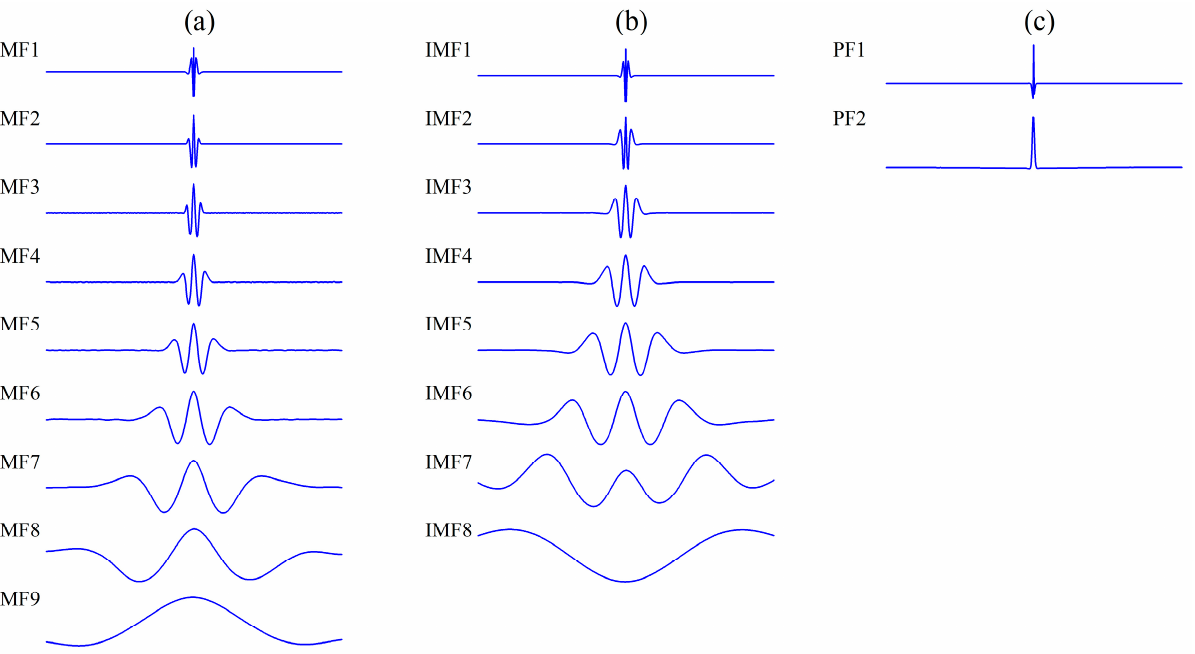
Figure 1. Decomposition results of δ ( t ) : ( a ) CEEMDAN ( b ) ICEEMDAN and ( c ) CCERLMDAN. (Setting the same noise standard deviation parameter and ensemble number parameter in three methods).